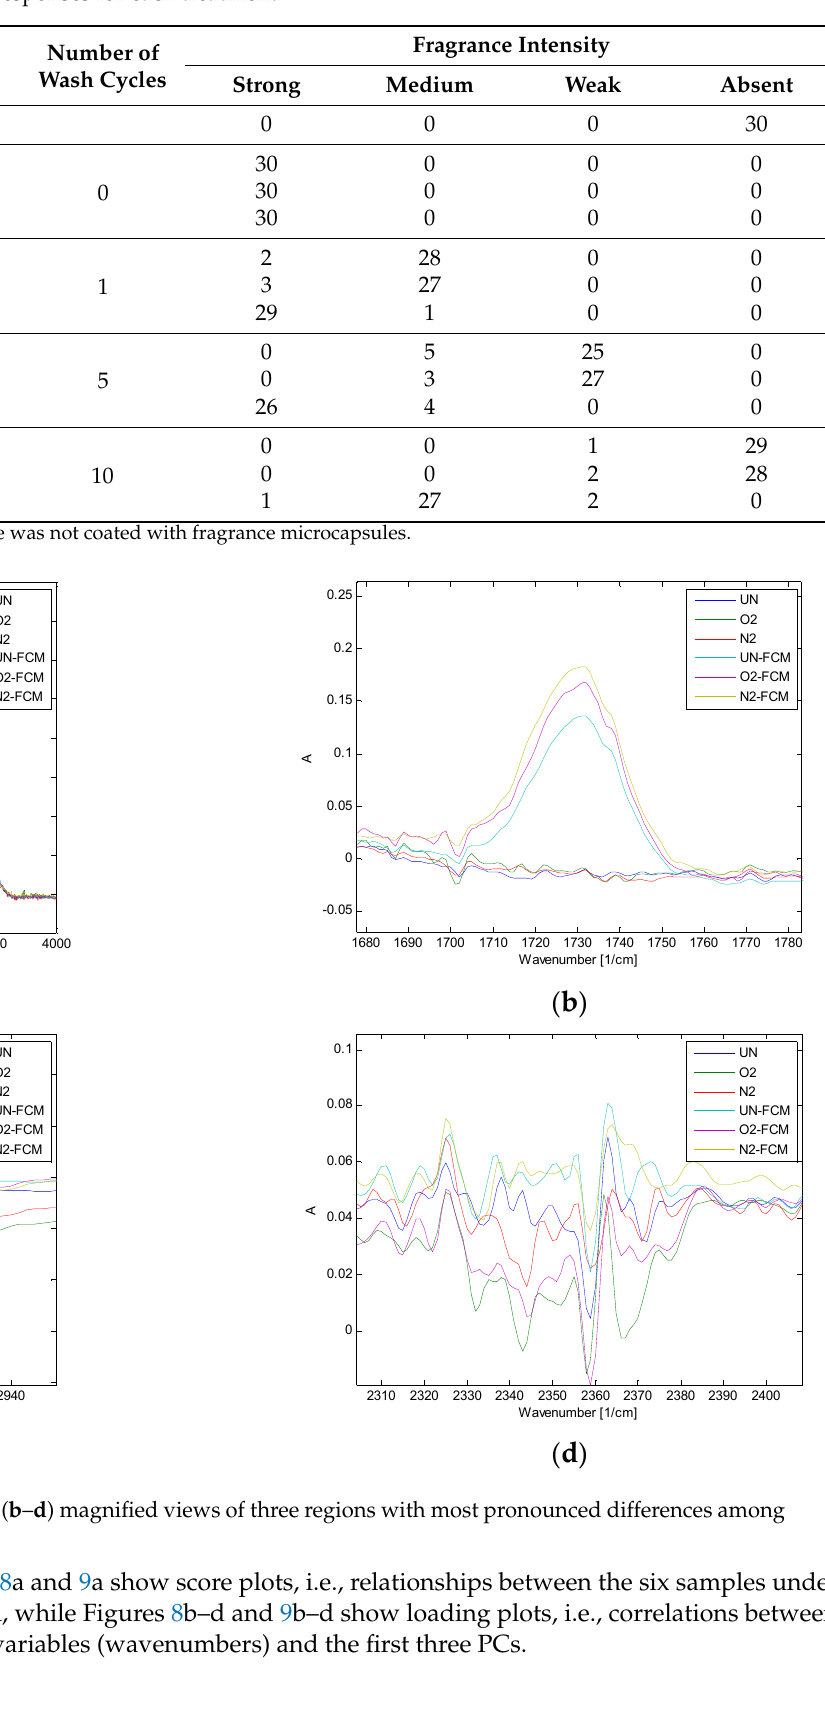
Table 4. Fragrance intensity of unwashed and washed microcapsule-coated cotton fabrics expressed as number of responses for each treatment.